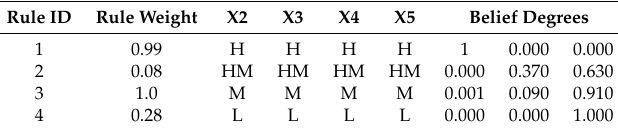
Table 12. Trained BRB for disjunctive